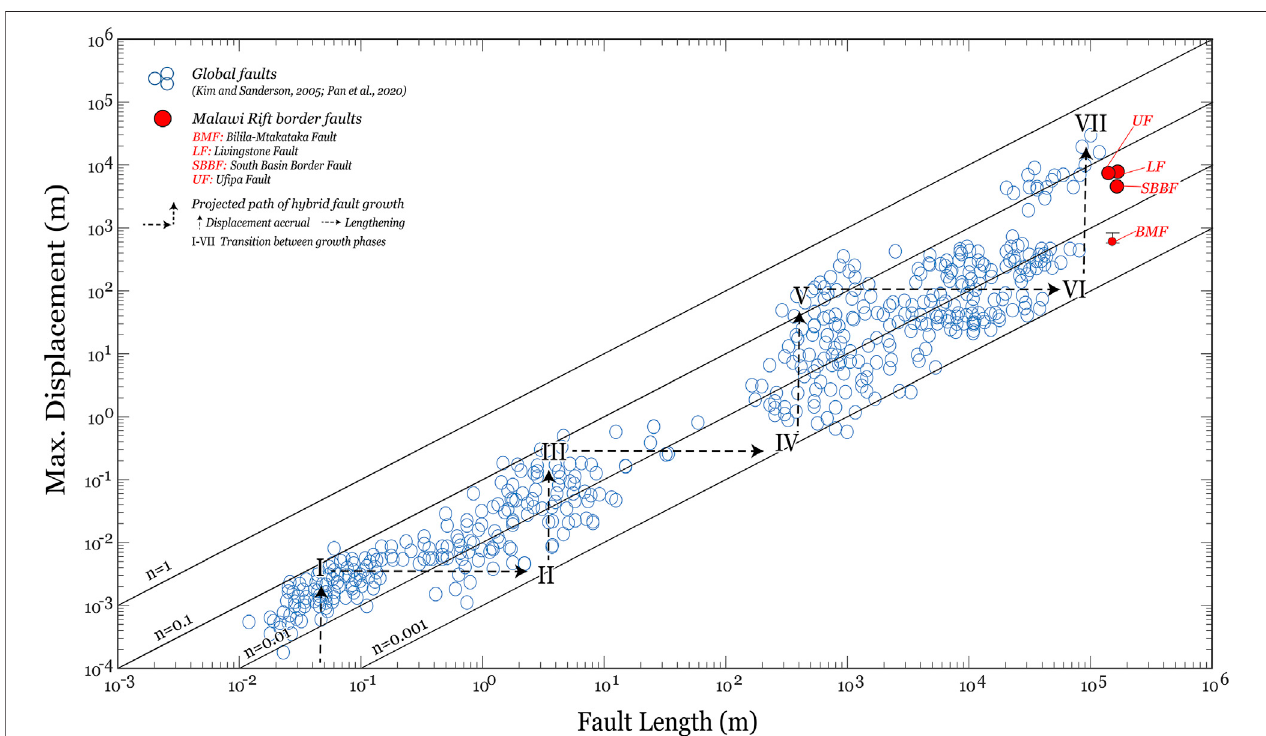
FIGURE 11 | Fault length trace along strike against maximum displacement relationship. The fi gure shows the stages of strain evolution (I – VII) the Bilila-Mtakataka (BMF) fault is compared with Livingstone Fault (LF) Usisya Fault (UF) and South Basin Border Fault (SBBF) (Specht and Rosendahl, 1989; Scholz et al., 2020; Shillington et al., 2020) and the tendency for the faults to still accumulate more strain. The arrow lines show the path a fault would follow at different stages (I – VII) as it grows and evolve from initiation to termination (lengthening phase (horizontal arrows); isolated fault initiation and displacement accrual phase (vertical arrows); transition betweenthenormalfaultgrowthphases(I – VI);andatstageVII,faultbecomesinactive.TheglobalD-Lplotsweremodi fi edfromKimandSanderson,(2005)andPanetal.